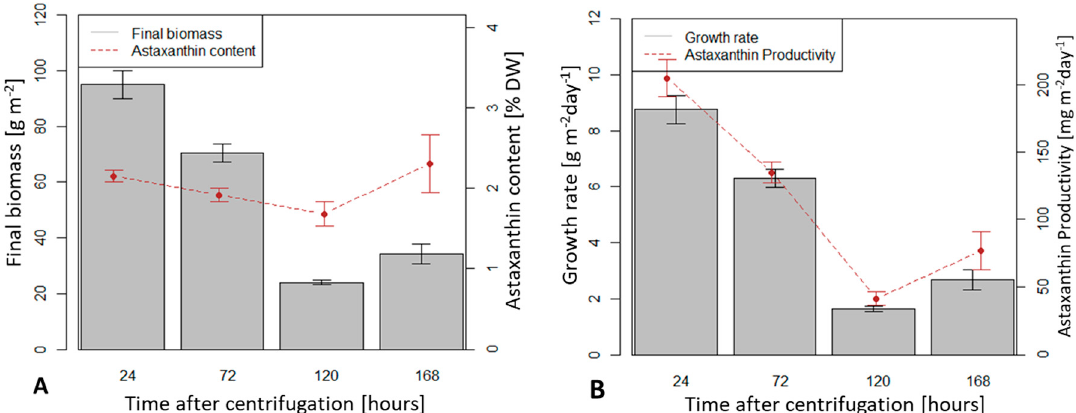
Figure 6. Biomass and astaxanthin in H. pluvialis at different storage times of initial biomass after centrifugation from suspension culture. ( A ) Final biomass and astaxanthin content; ( B ) Growth rate (average of biomass increase in 10 days) and astaxanthin productivity.